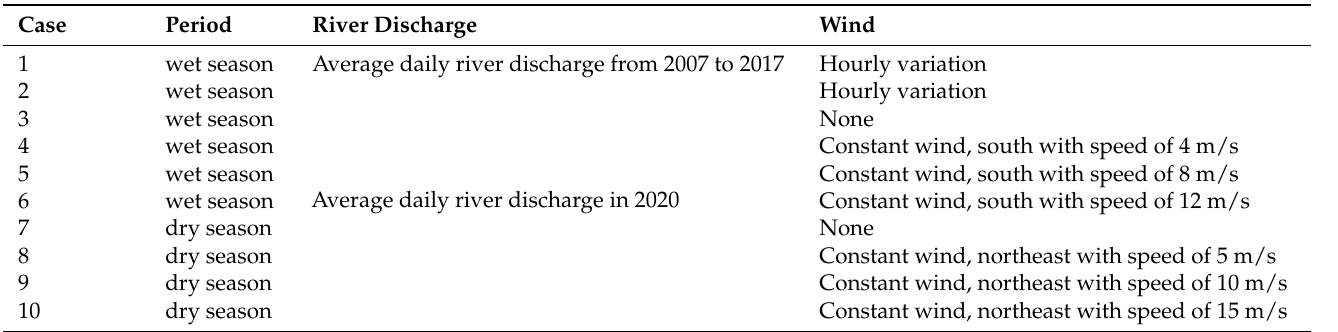
Table 3. Description of numerical